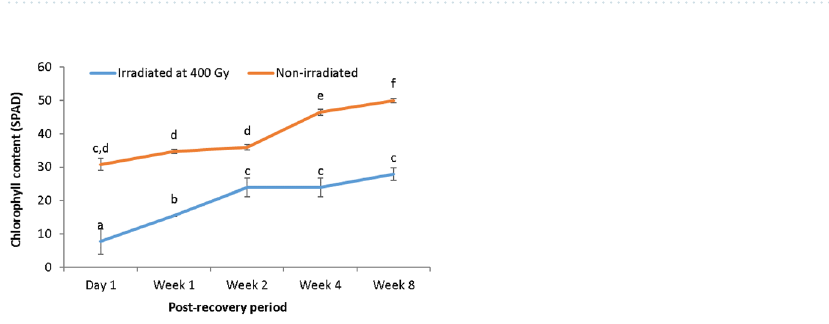
Figure 1. ( a ) Plantlet height, and ( b) leaf width at five different post-recovery periods after being irradiated with gamma at 400 Gy. *significantly different at p < 0.05.